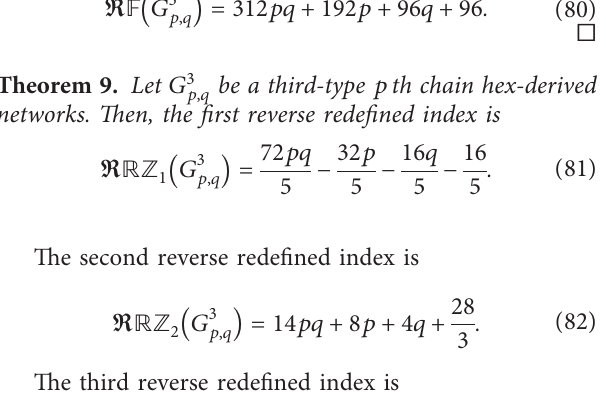
Table 2: Numerical comparison of R ABC , R GA , R M